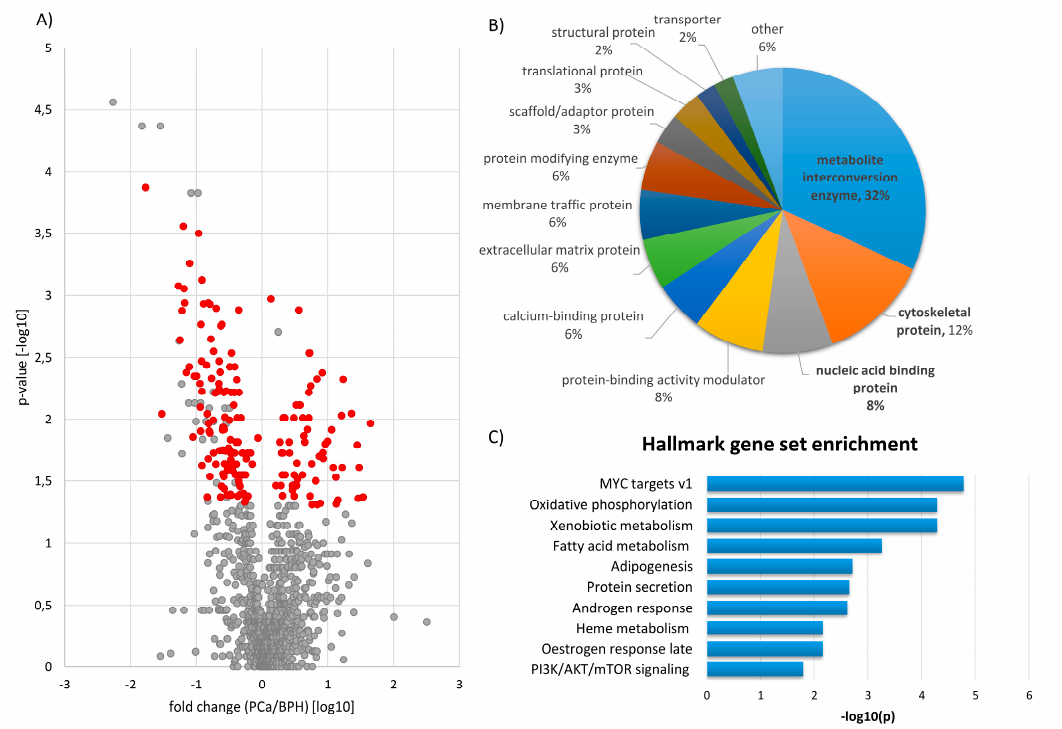
Figure 2. Protein differences between patients with PCa and BPH: ( A ) Volcano plot. Proteins that were identified only in one of the two groups were not plotted. The latter covers 217 and 50 proteins found solely in the case (PCa) and the control (BPH) groups, respectively. Differentially abundant proteins (significant change in the abundance ( p < 0.05), detected in more than 30% of samples) are shown in red. ( B ) Distribution of protein classes of differentially expressed proteins: Protein classes were defined according to the Panther Classification System. Information on the protein class was available for 88 out of 145 differentially abundant proteins . ( C ) Graphical representation of the enrichment analysis based on Molecular Signatures Database (MSigDB) hallmark gene set ontology: the ten most significantly enriched terms are presented. p -values were calculated using the